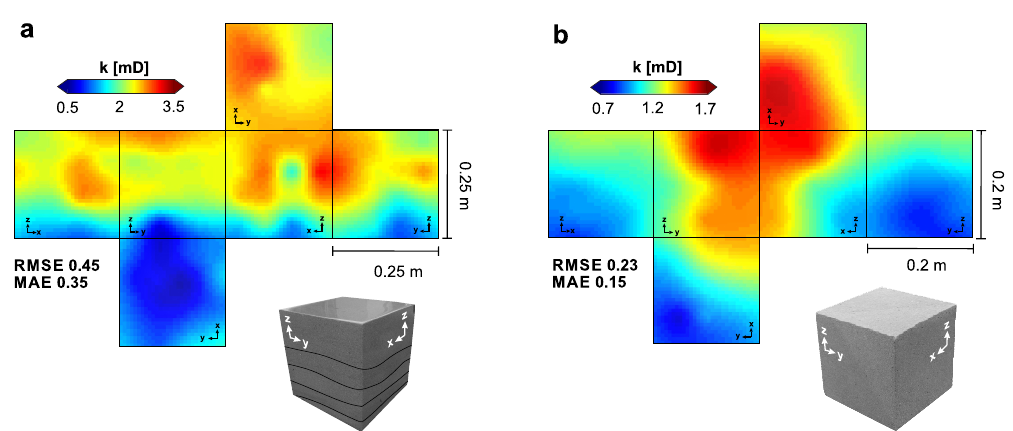
Figure 6. Spatial distribution of the intrinsic permeability in the rock cubes OSB1_c ( a ) [40] and OSB2_c ( b ) interpolated using the SK method.